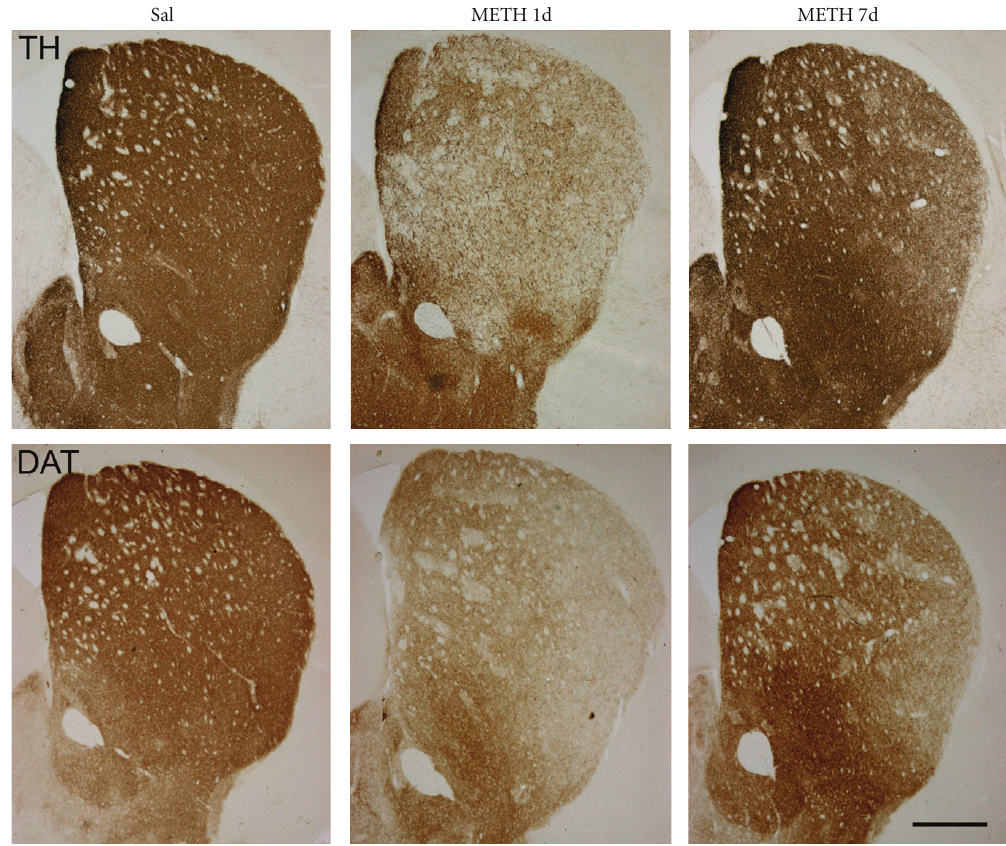
Figure 1: Time-course of TH and DAT fiber lost change after methamphetamine administration. Photomicrographs of striatal sections from mice treated with saline or METH stained for TH and DAT to illustrate the loss (1 day) and the partial recovery (7 days) of dopamine fibers that occur after methamphetamine administration. Animals were killed 1 and 7 days after treatment. Bar indicates 500 𝜇